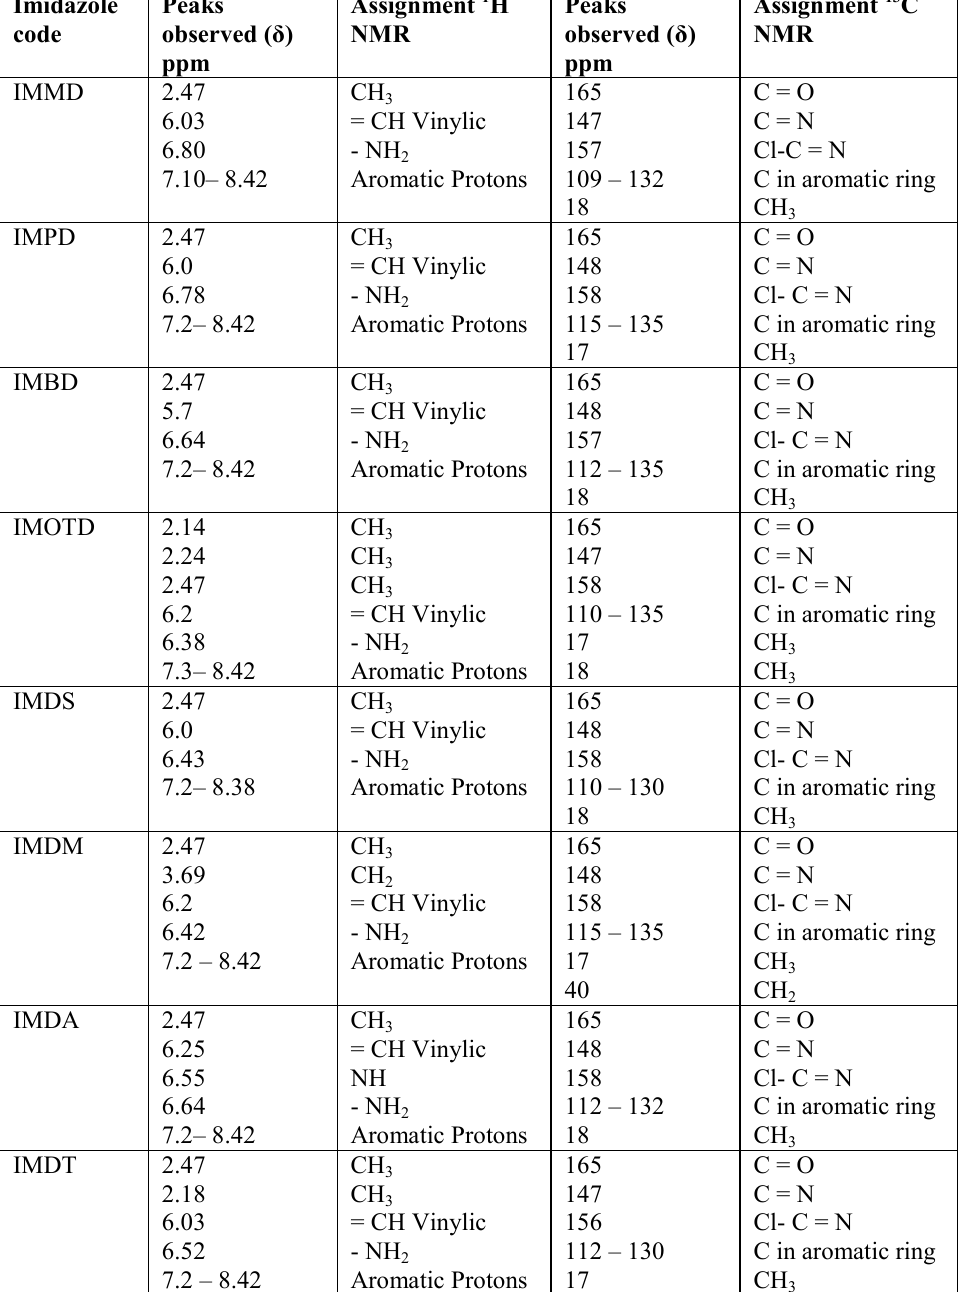
Table 2. Assignment of NMR ( 1 H and 13 C) peaks in imidazole derivatives of 2-chloro-7- methyl-3-formyl